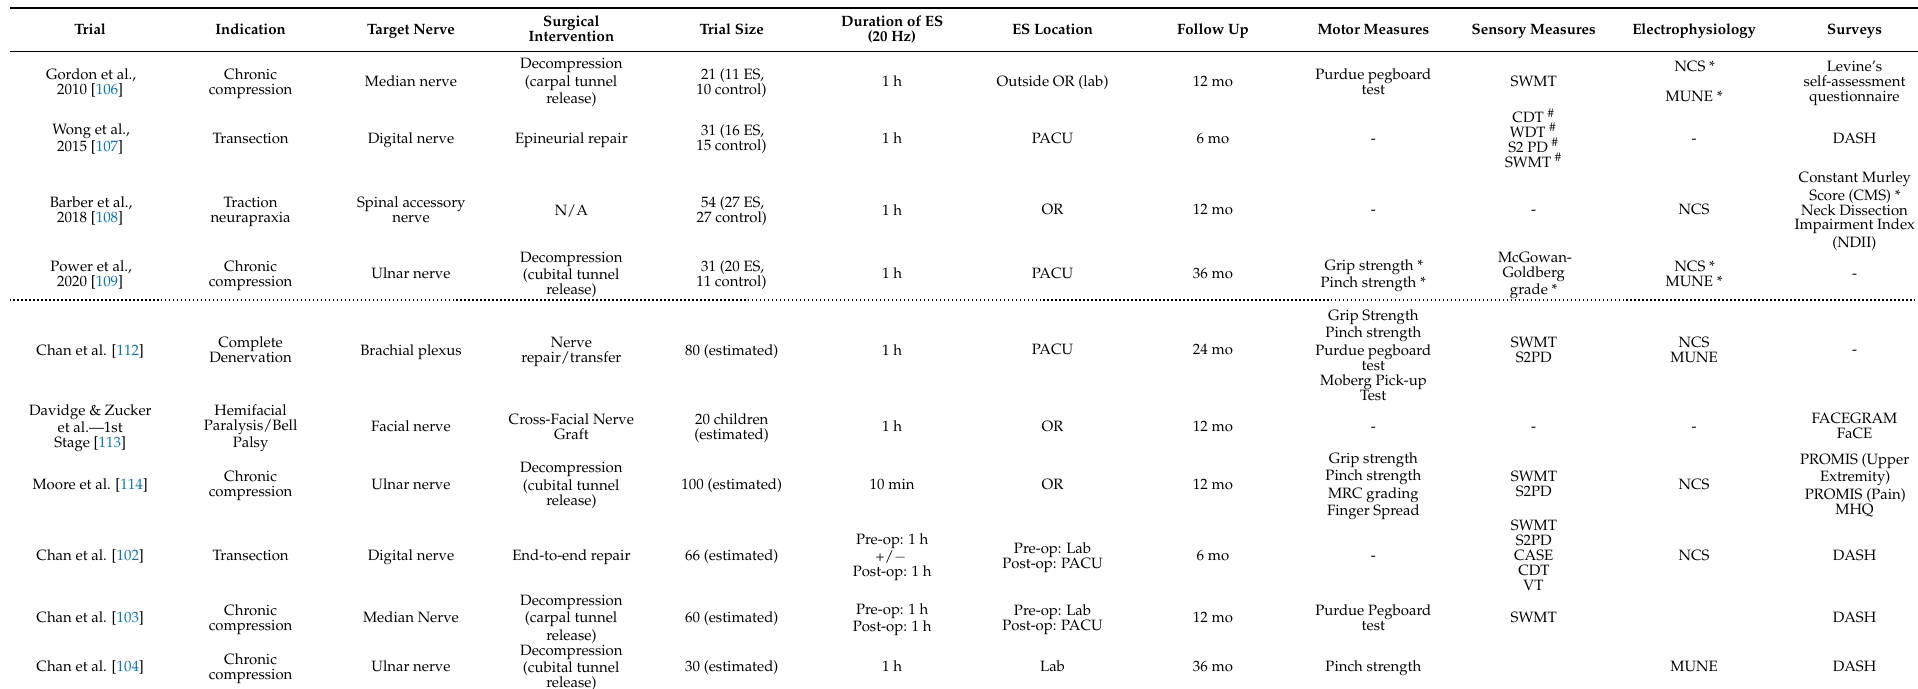
Table 1. Summary of clinical trials of perioperative ES following PNI—ongoing trials below dashed